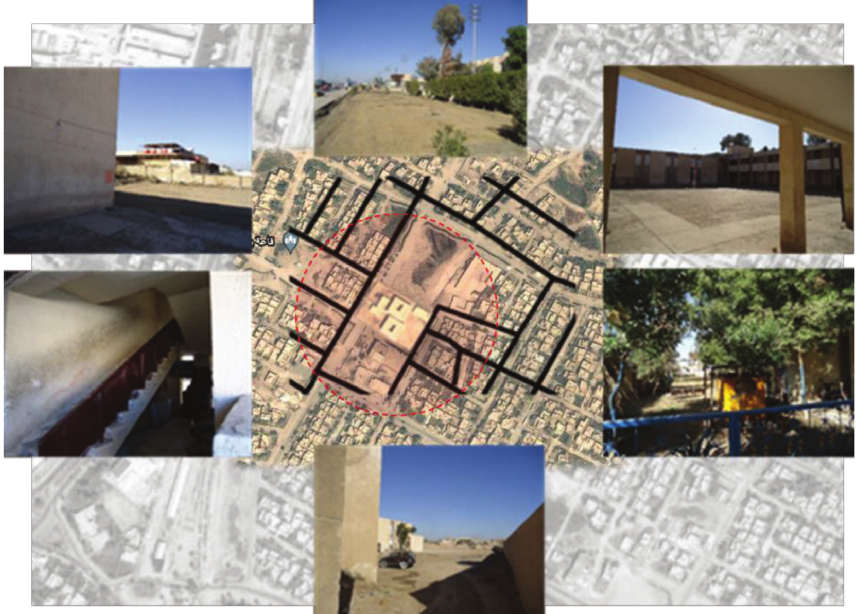
Figure 3: The general site for Al-Buhtari School for